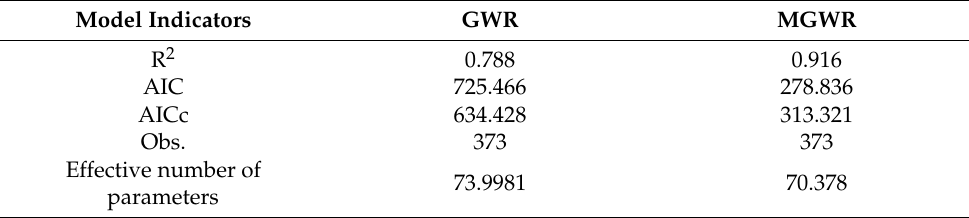
Table 13. Model indicators of GWR and